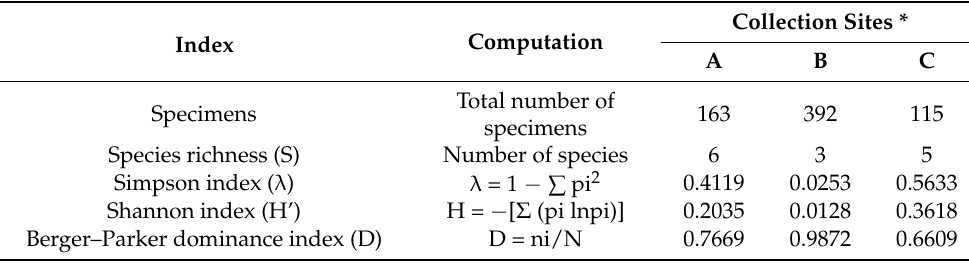
Table 3. Diversity indices of the sand flies from the collection sites at three different altitudes in the Lombardy region in 2021 * (A = 10–200 m a.s.l., B = 200–300 m a.s.l., and C = over 300 m